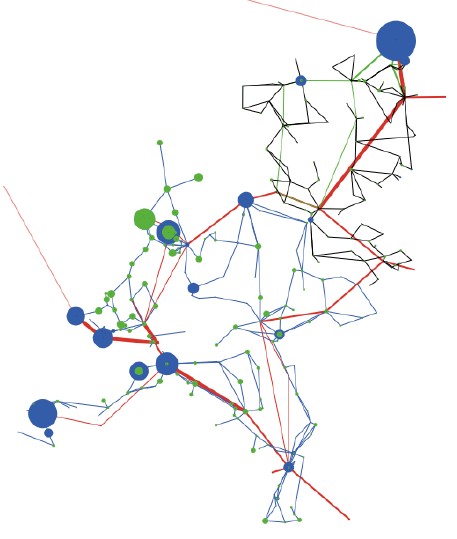
Figure 2. Geographically explicit representation of the employed dataset describing the Dutch electricity infrastructure. Blue circles represent (clusters of) generators. Green circles represent distribution grids. Edges represent transmission lines and international interconnectors (red = 380kV+, green = 220kV, blue = 150kV, black = 110kV). Substations lie at the connection points of transmission lines. The size of generators and distribution grids is determined by the relative magnitude of their generation capacity or peak demand,